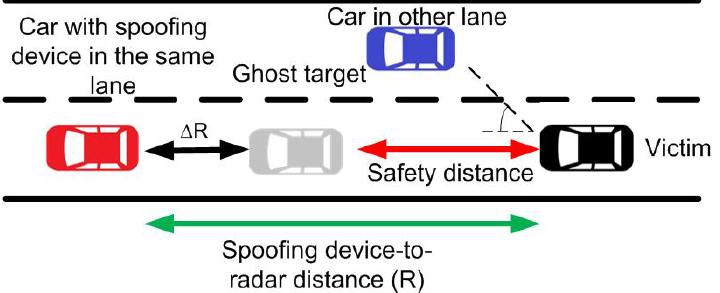
Figure 2. Scheme of a car-following model where the victim radar experiences a spoofing attack from a device installed in a car in the same lane, introducing a false target less than a safe distance